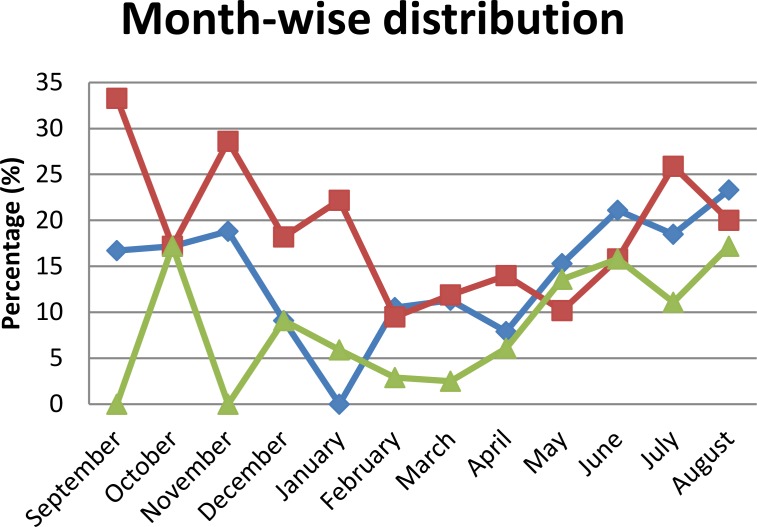
Month-wise distributions of antibodies against DENV infection, from March 2016 to May 2017.Blue diamonds: study participants with only anti-DENV IgM positive cases; red squares: study participants with only anti-DENV IgG positive cases; green triangles: study participants with both IgM and IgG positive cases.